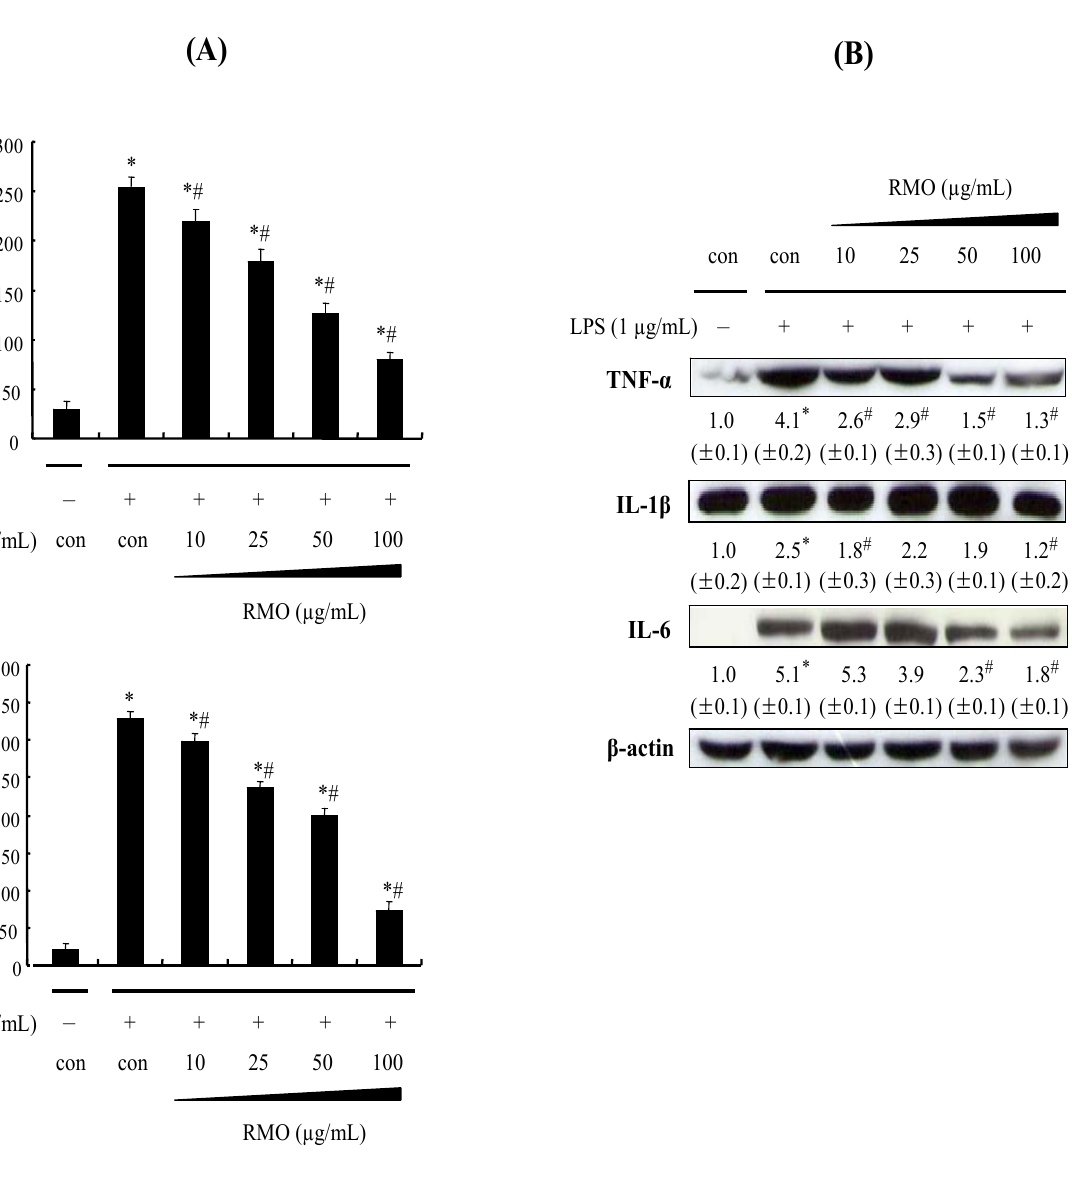
Figure 3. RMO inhibited the production of LPS-induced pro -inflammatory cytokine in RAW 264.7 cells. ( A ) RAW 264.6 cells were pretreated with RMO for 1 h, and then stimulated with LPS (1 μ g/mL). Culture media were collected after 24 h in order to measured TNF- α and IL-6 concentrations using ELISA. Data are presented as the means ± S.D. of three independent experiments. *, # Significantly different from the no treatment and LPS-treated control, respectively ( p < 0.05). ( B ) The cells were incubated with RMO in the presence or absence of LPS for 24 h. Then the cells were harvested and whole cell extracts were prepared for Western blot analysis for the indicated proteins. The results are expressed as the means ± S.D. for three separate experiments, each with three